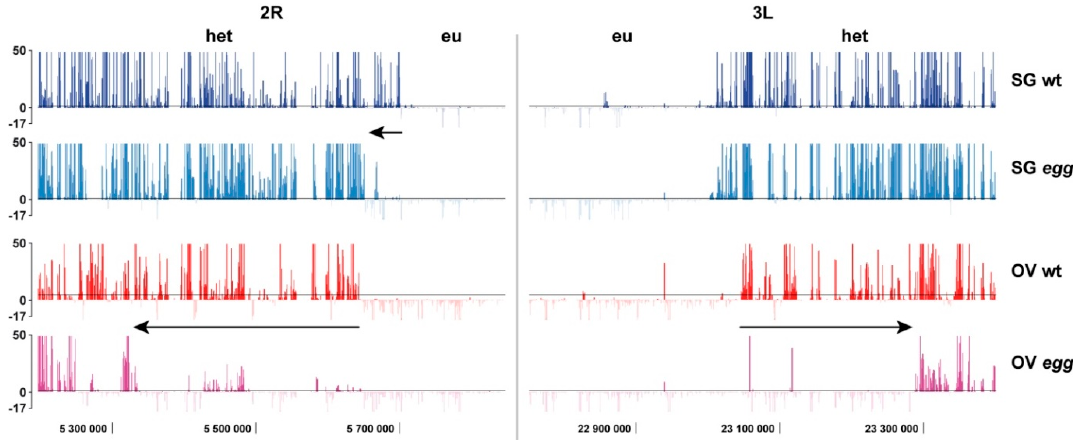
Figure 4. The border between euchromatin (eu) and heterochromatin (het) in the chromosome arms 2R and 3L in the salivary glands (SG) and germline cells of the ovary (OV) from wild type (wt) and egg mutants. Data for SG wt are taken from [28], the rest of the profiles are obtained in this study. Axis labels are the same as in Figure 2. Arrows point to the shift between the positions of the border between thegenotypes.